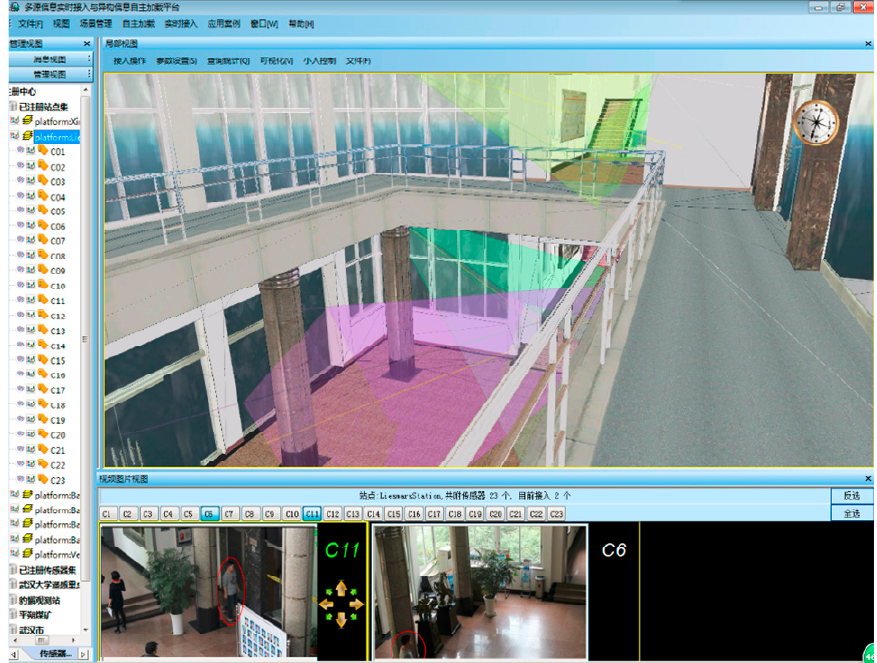
Figure 6. The visual effect of Video graphic information systems (GIS) platform based on GeoVideo